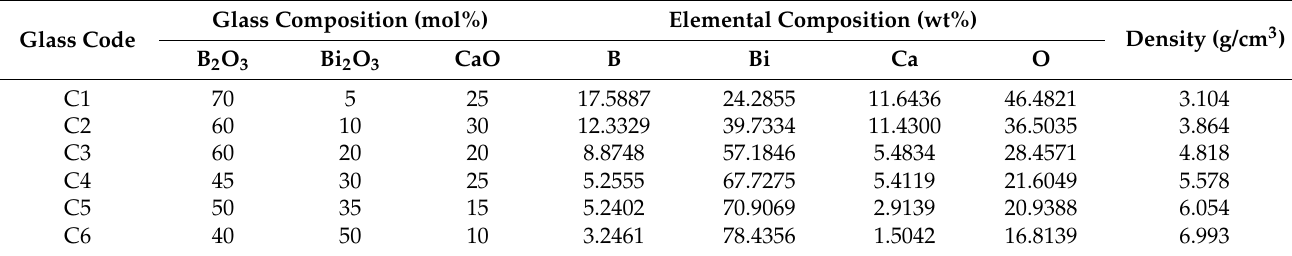
Table 1. Chemical composition (mol%) and elements (wt%) present in the selected B 2 O 3 -Bi 2 O 3 -CaO glasses, including their density